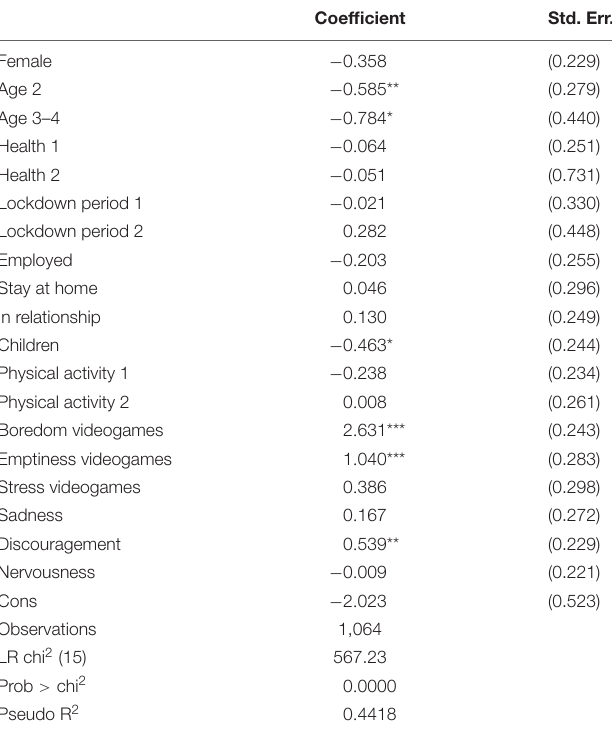
Table 1 and Supplementary Appendix Table A1 . Results of the multinomial logit regression with four separate categories are available upon request to the authors. TABLE 5 | Logistic regression on videogame play increase.